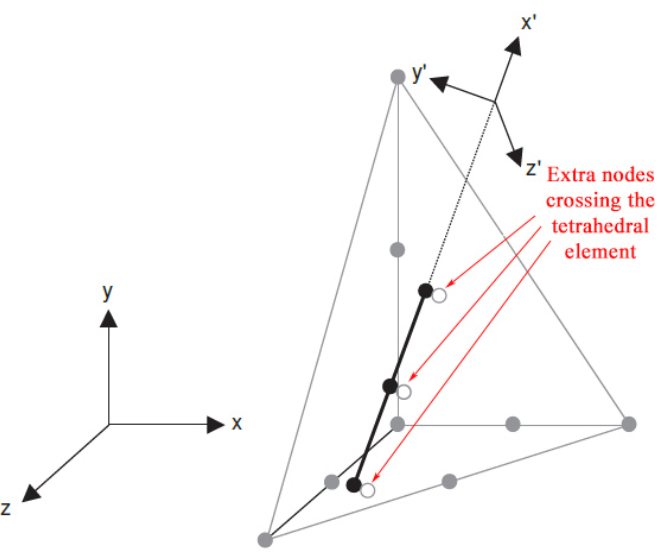
Figure 20. Embedded beam element (After Brinkgreve et al. [45], modified).